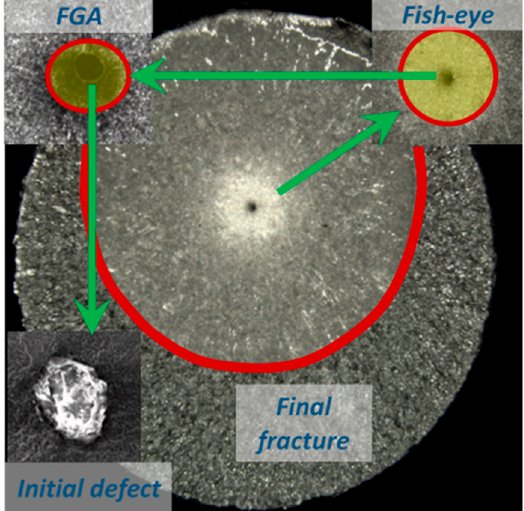
Figure 4. Typical fish-eye morphology, which was experimentally found and observed with a scanning electron microscope.